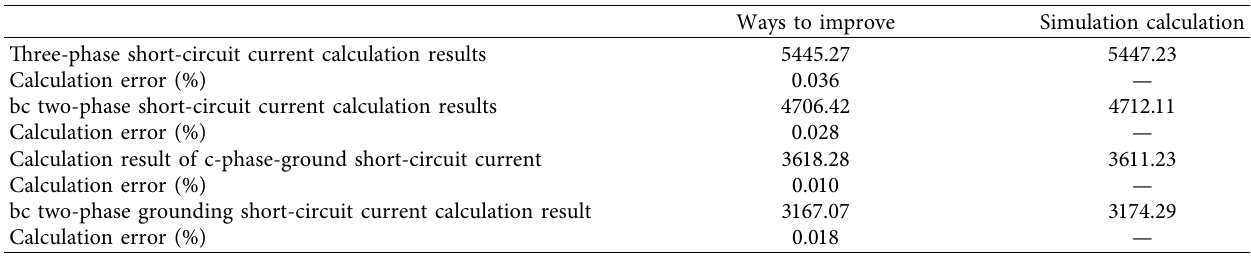
Table 2: Calculation results of short-circuit current in distributed power distribution network when one node fails.